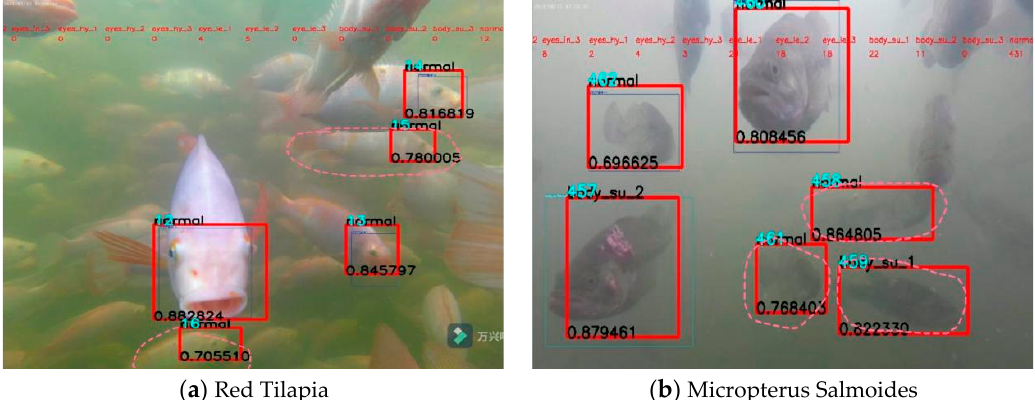
Figure 12. Comparison of the test image results.